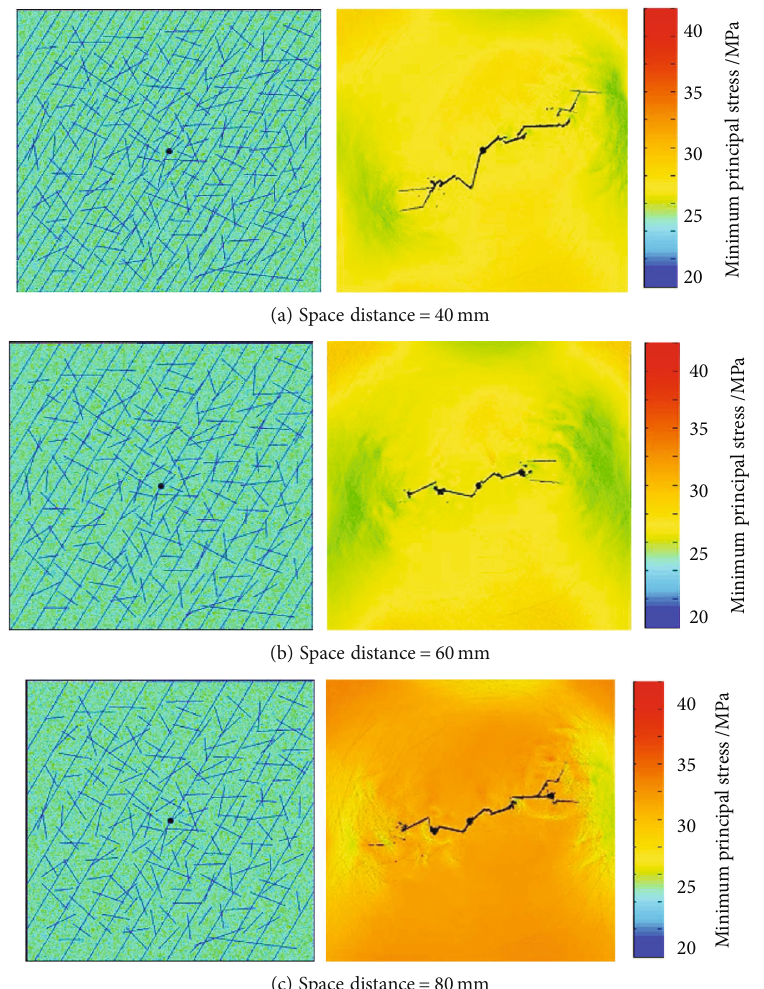
Figure 21: Fracture propagation having natural fractures and bedding plane with di ff erent development densities [55].